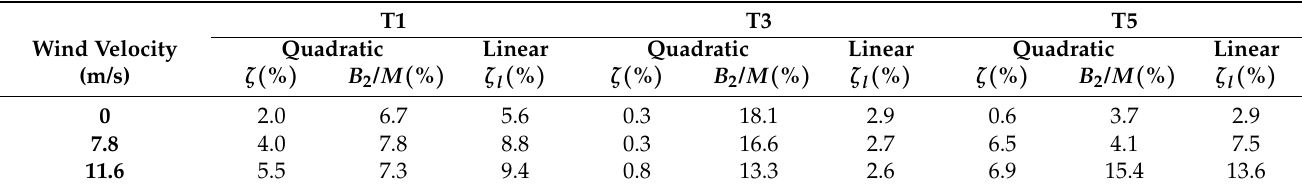
Table 6. Experimental results for surge, heave and pitch linear and quadratic, and linearized damping ratios for each wind condition.